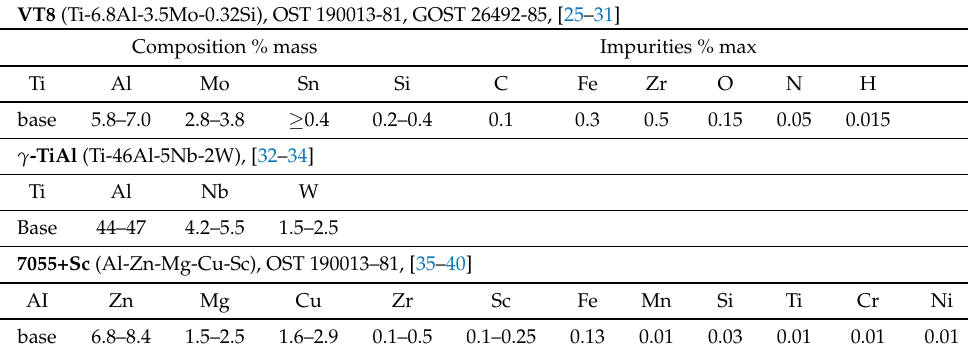
Table 2. Analysed alloys, their composition and related